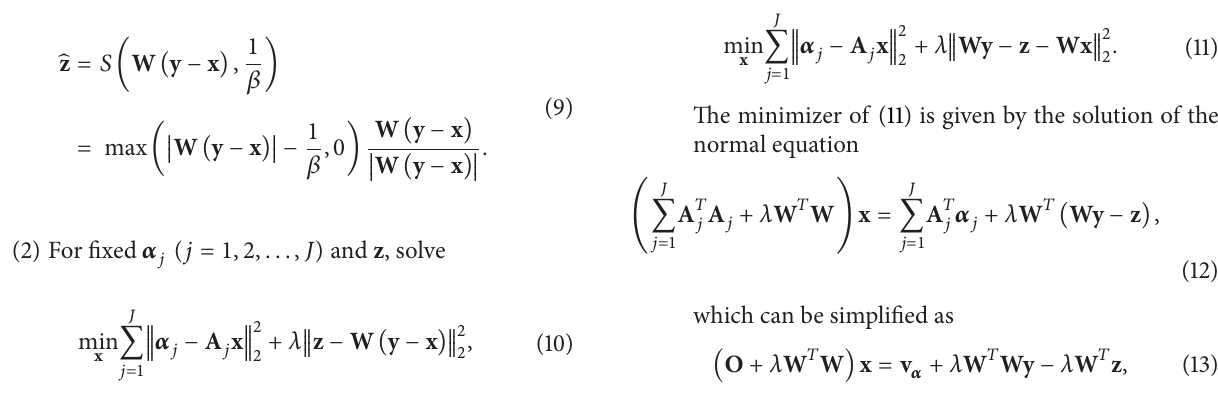
whose solution is obtained via soft